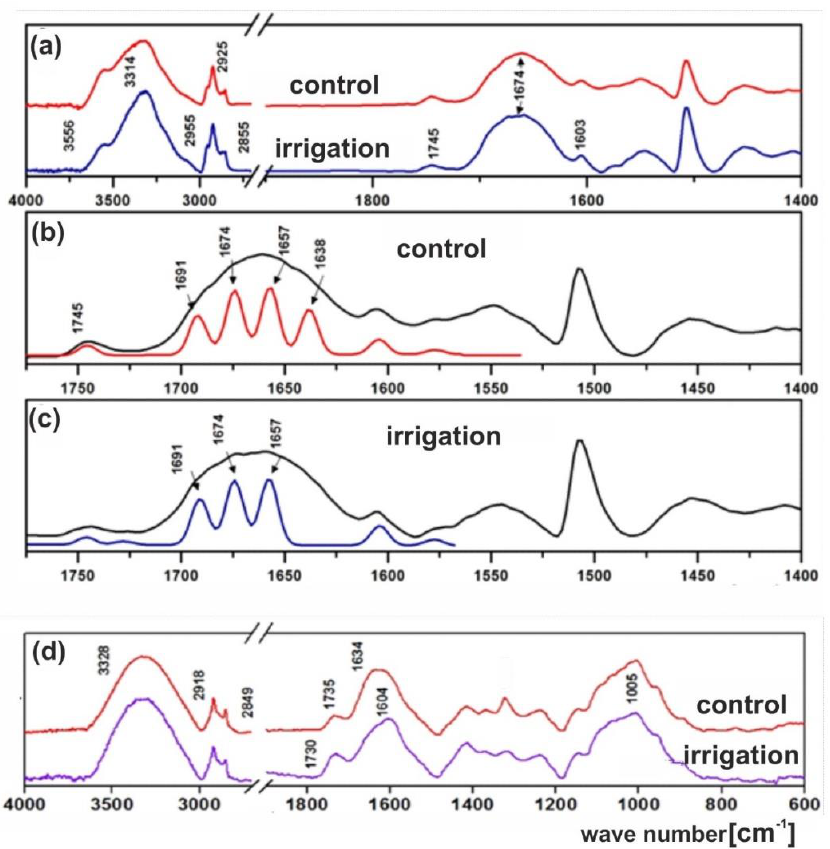
Figure 4. Fourier transform–infrared spectroscopy (FT-IR) spectrum of the yellow lupine seeds: ( a ) peeled seeds collected from the control (not irrigated) and irrigated lupine plants, ( b ) separation of the overlapping bands in the spectrum of the control seed—four Gaussian lines (red line) were found at 1691, 1674, 1657 and 1638 cm −1 , ( c ) separation of the overlapping bands in the spectrum of the irrigated seed—three Gaussian lines (navy line) were found at 1691, 1674, and 1657cm −1 . Spectra were